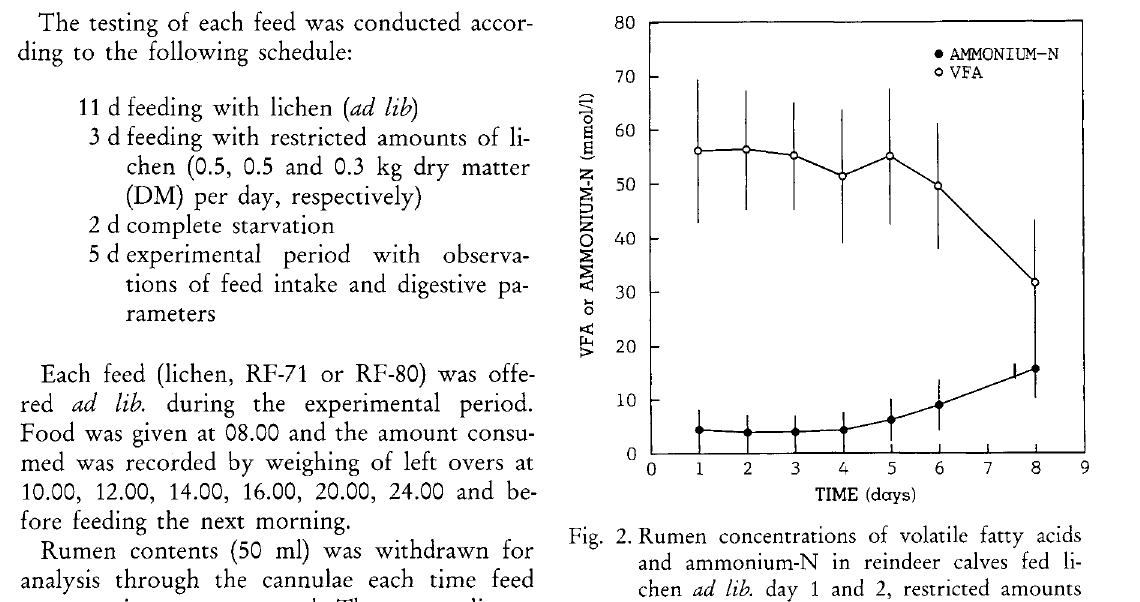
Fig. 2. Rumen concentrations of volatile fatty acids and ammonium-N in reindeer calves fed li chen ad lib. day 1 and 2, restricted amounts of lichen on days 3-5, and no feed for the rest of the period. The data shown are avera ges and standard deviations of three samples per day from each of 7